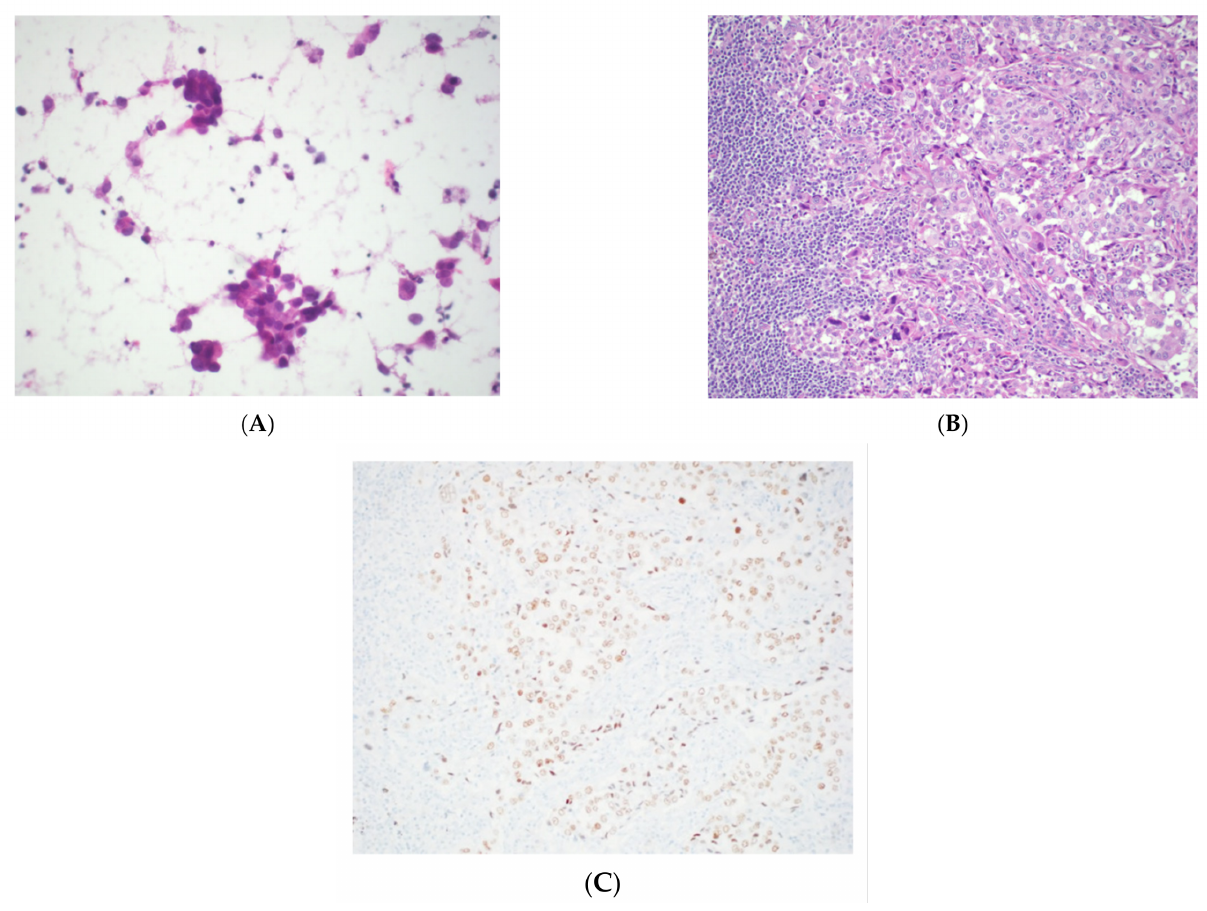
Figure 10. Metastatic lung adenocarcinoma. ( A ) Thymic smear showing overtly malignant cell clus- ters with mucinous cytoplasm suggestive of adenocarcinoma. H&E stain, 40 × objective. ( B ) Resection shows an epithelial malignancy. Primary thymic and lung adenocarcinomas are morphologically indistinguishable. However, radiographic findings of a lung mass increase suspicion for a metastatic tumor. H&E stain, 20 × objective. ( C ) Reactivity for TTF-1 rules out thymic origin and is consistent with a diagnosis of metastatic lung adenocarcinoma. Magnification: 20 ×